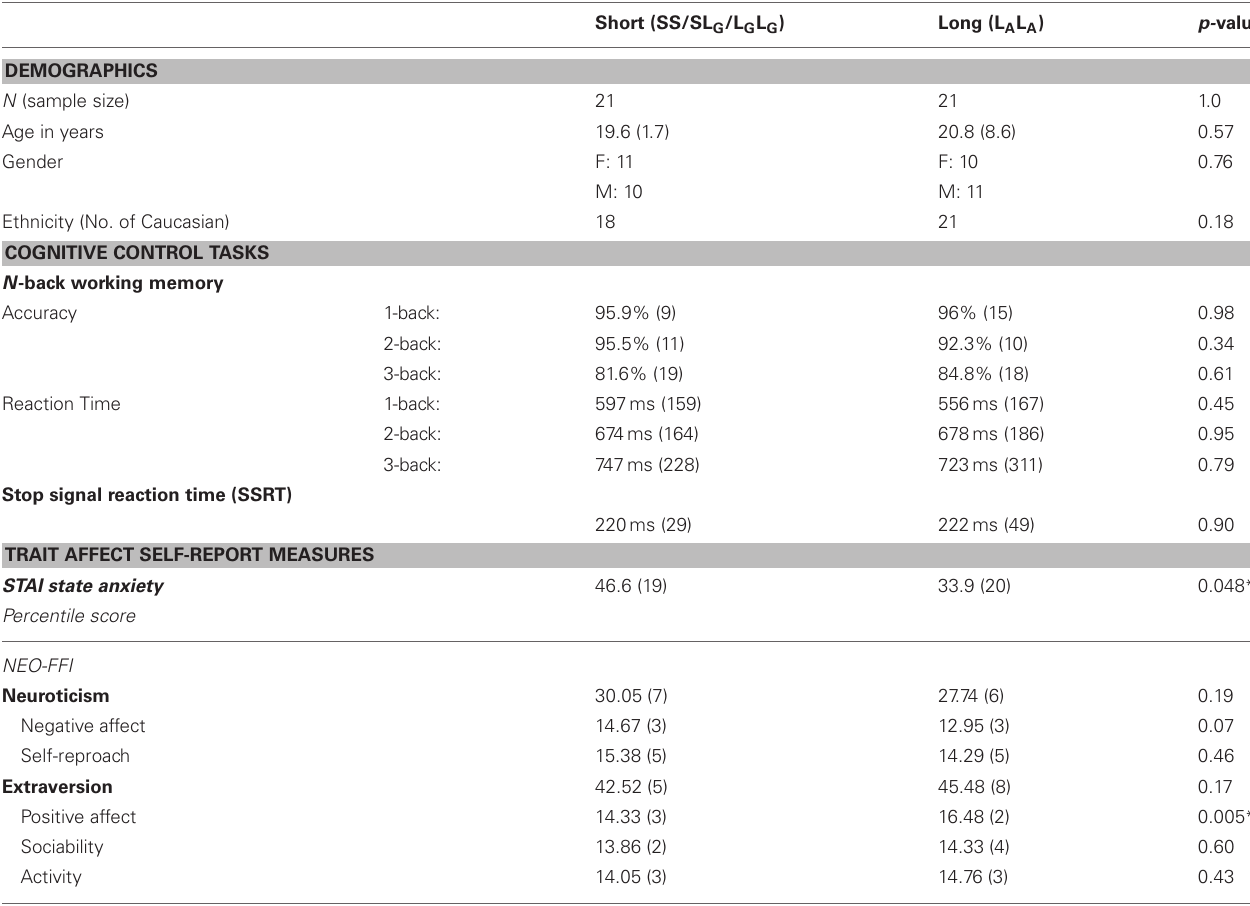
Table 1 | Demographics, cognitive control, and trait affect measures for short and long 5-HTTLPR genotype groups; mean